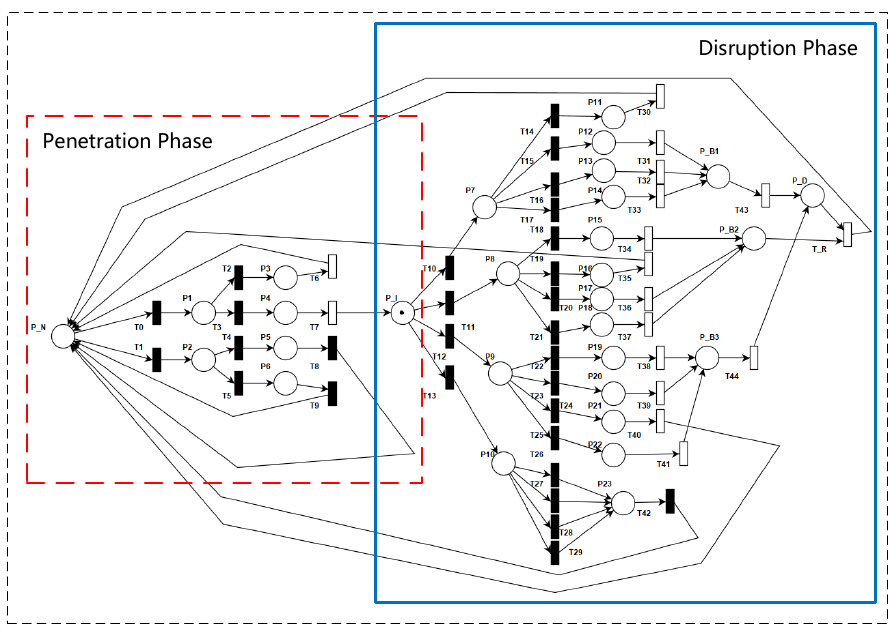
Figure 4. Attack–defense confrontation